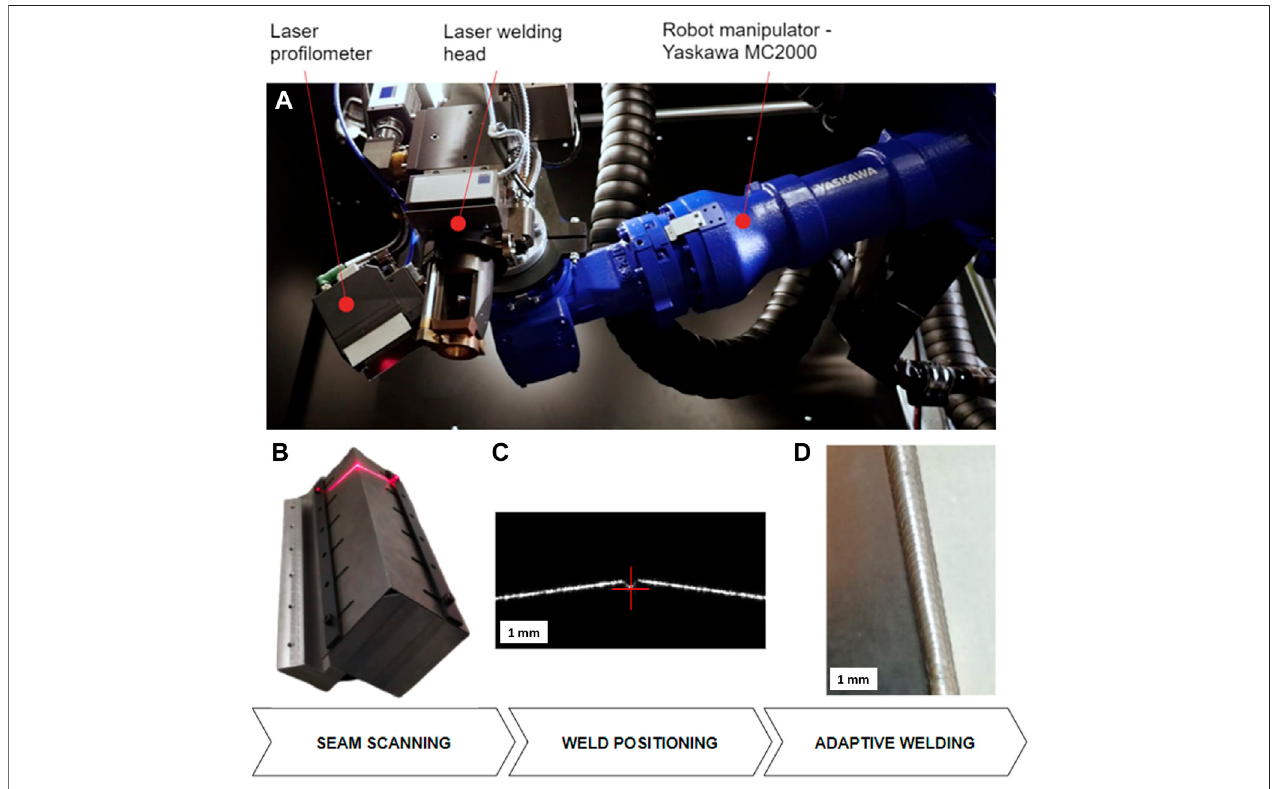
FIGURE 8 | Example of the adaptive laser system (A) for welding of thin steel plates. The process is composed of seam 3D scanning (B) , detection of the welding edge (C) , and laser welding along the detected path (D) .